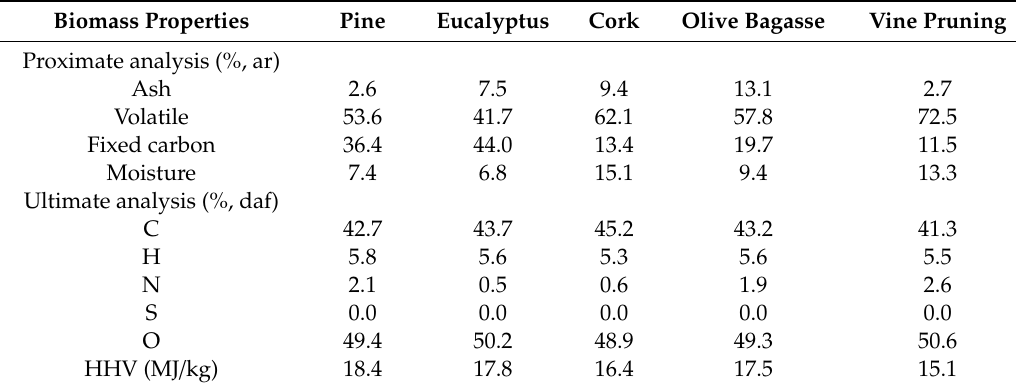
Table 6. Characterization of selected